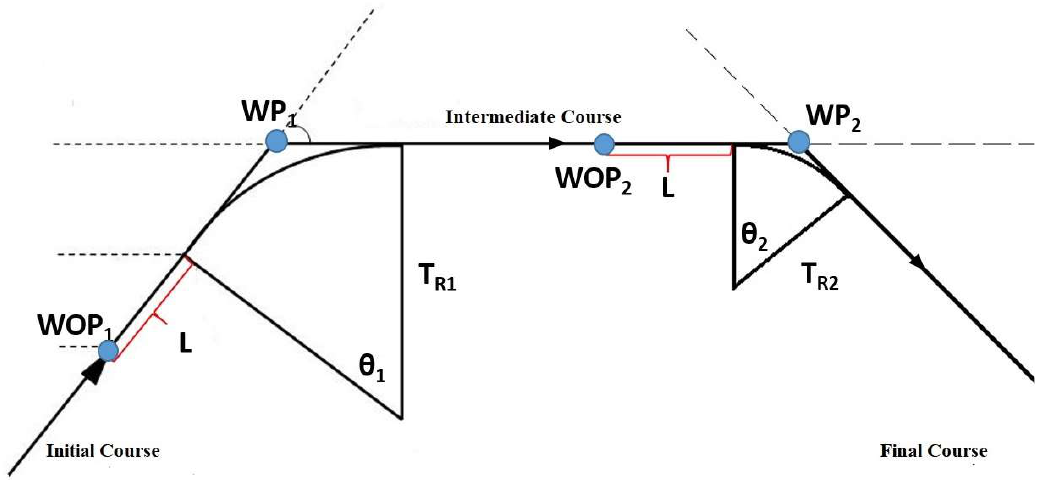
Figure 4. Simplified manoeuvring scheme.